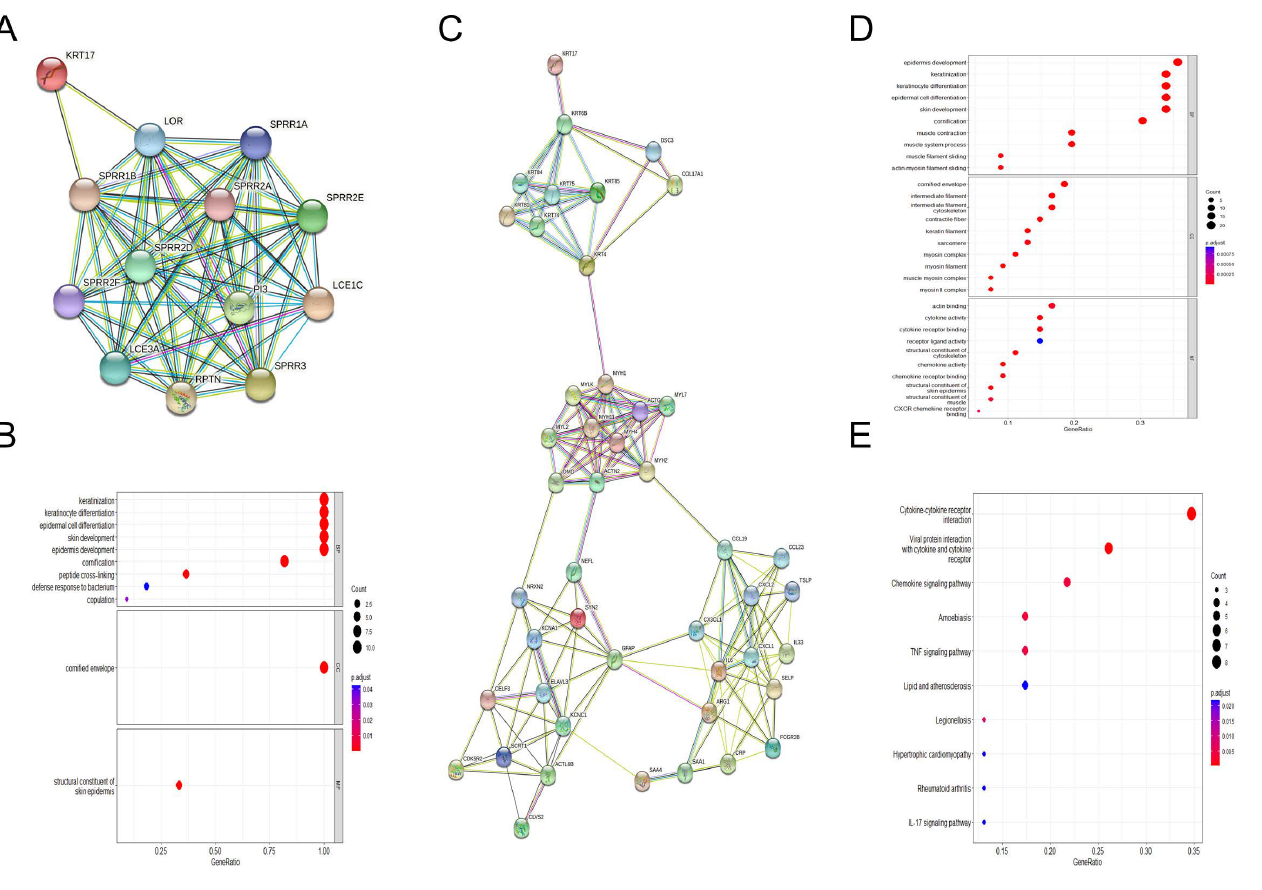
Figure 6. PPI network and functional module analyses in HER2 high BC. ( A ) Network of functional module 1. ( B ) GO analysis of module 1. ( C ) Network of functional module 3. ( D ) GO analysis of module 3. ( E ) KEGG analysis of module